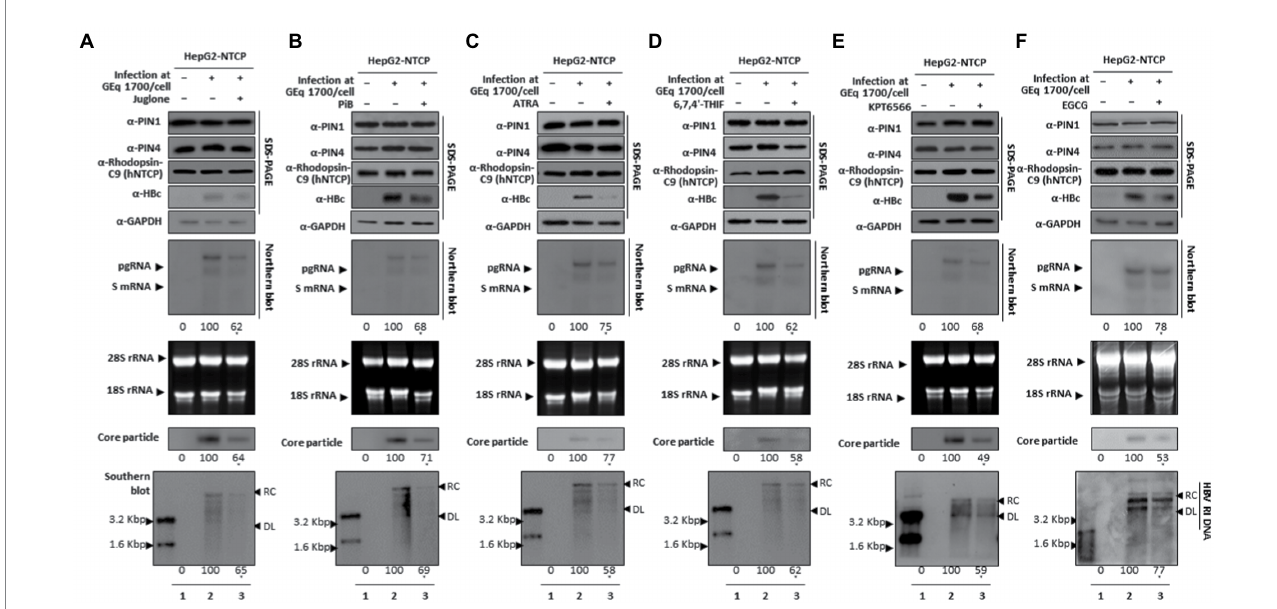
FIGURE 9 PIN1 and PIN4 Inhibition via Juglone, PiB, ATRA, 6,7,4 ′ -THIF, KPT6566, and EGCG abrogate HBV replication in HBV-infected cells. (A) Juglone, (B) PiB, (C) ATRA, (D) 6,7,4 ′ -THIF, (E) KPT6566, and (F) EGCG restricted HBV replication in infected cells. HepG2-hNTCP-C9 cells were seeded and infected, as described previously, in the “Material and Methods” section. Infected cells (lanes 2–3) were treated with solvent (lane 2) or 20 μ M Juglone, 20 μ M PiB, 30 μ M ATRA, 30 μ M 6,7,4 ′ -THIF, 30 μ M KPT6566, 40 μ M EGCG (lane 3) for 9 days, and lysates were subjected to SDS-PAGE and immunoblotting, NAGE, Northern blotting, and Southern blotting. The shown data are representation from three independent experiments. The statistical significance was determined by